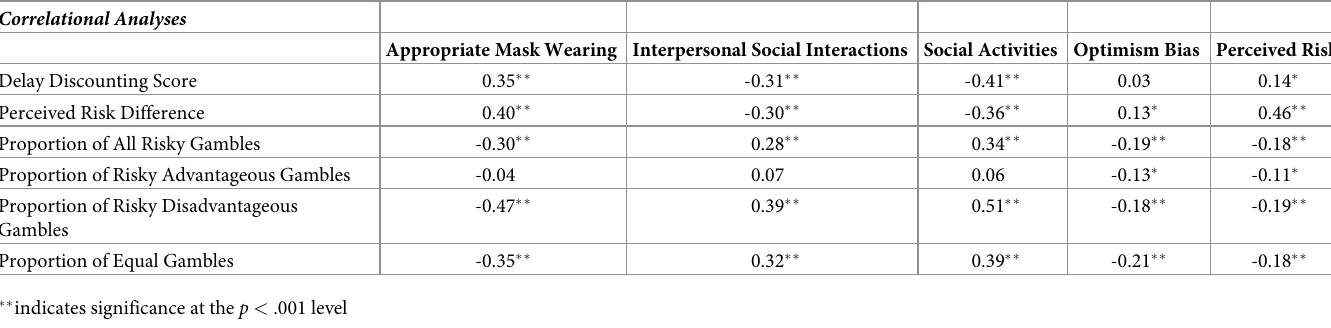
Table 4. Correlational Analyses Appropriate Mask Wearing Interpersonal Social Interactions Social Activities Optimism Bias Perceived